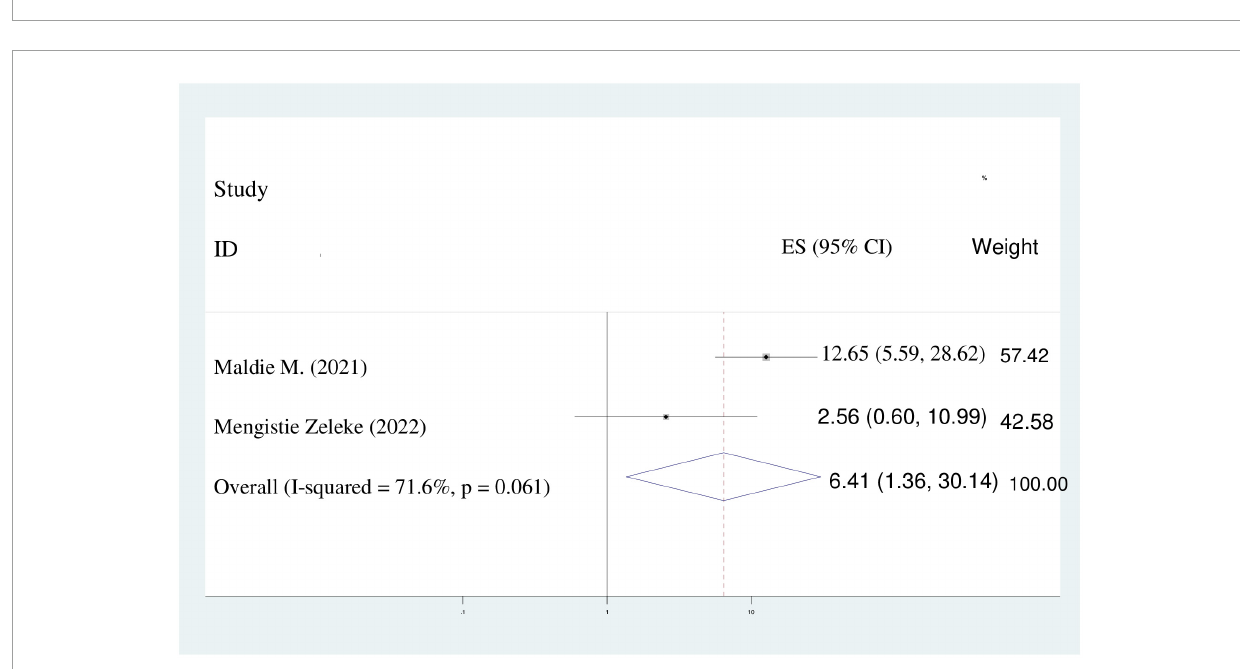
FIGURE9 Pooled odds ratio displaying the association of presence of complications during childbirth with disrespect and